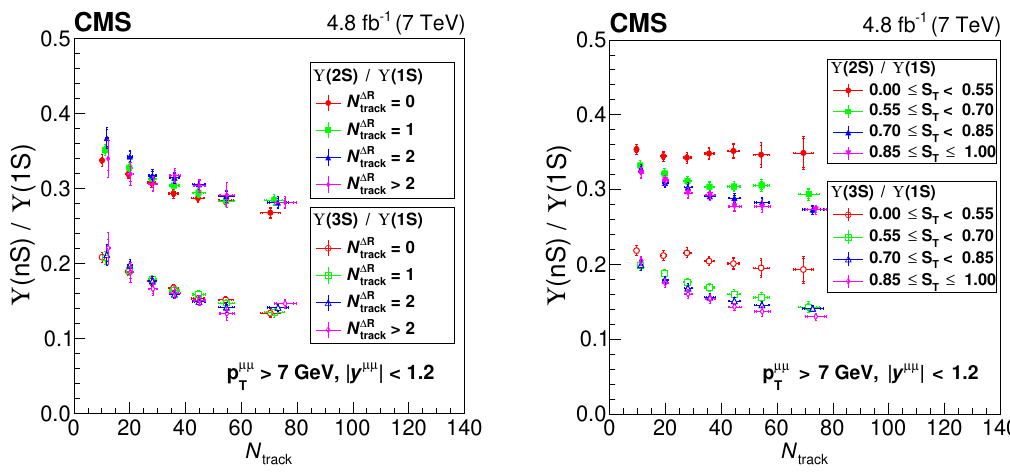
Figure 6 . The ratios (cid:7) (2S) = (cid:7) (1S) and (cid:7) (3S) = (cid:7) (1S) are shown as a function of the track multi- plicity N : in four categories based on the number of charged particles produced in a (cid:1)R < 0 : 5 track cone around the (cid:7) direction (left), and in di(cid:11)erent intervals of charged particle transverse sphericity, S (right). The outer vertical bars represent the combined statistical and systematic uncertainties T in the ratios, while the horizontal bars give the uncertainty in show only the statistical uncertainty, both in the ratio and in